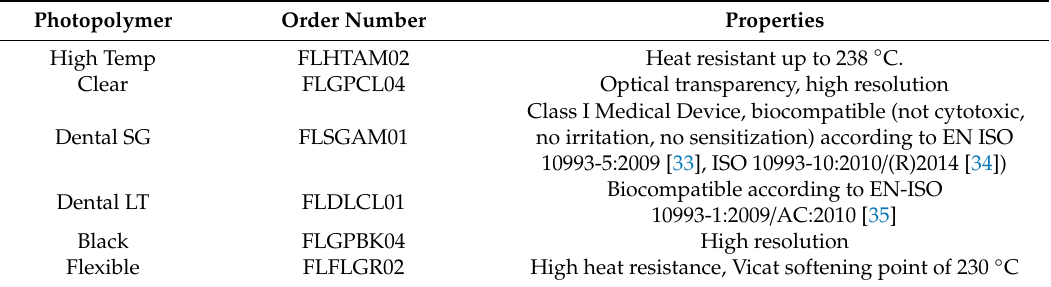
Table 1. Properties of the photopolymers tested for rapid